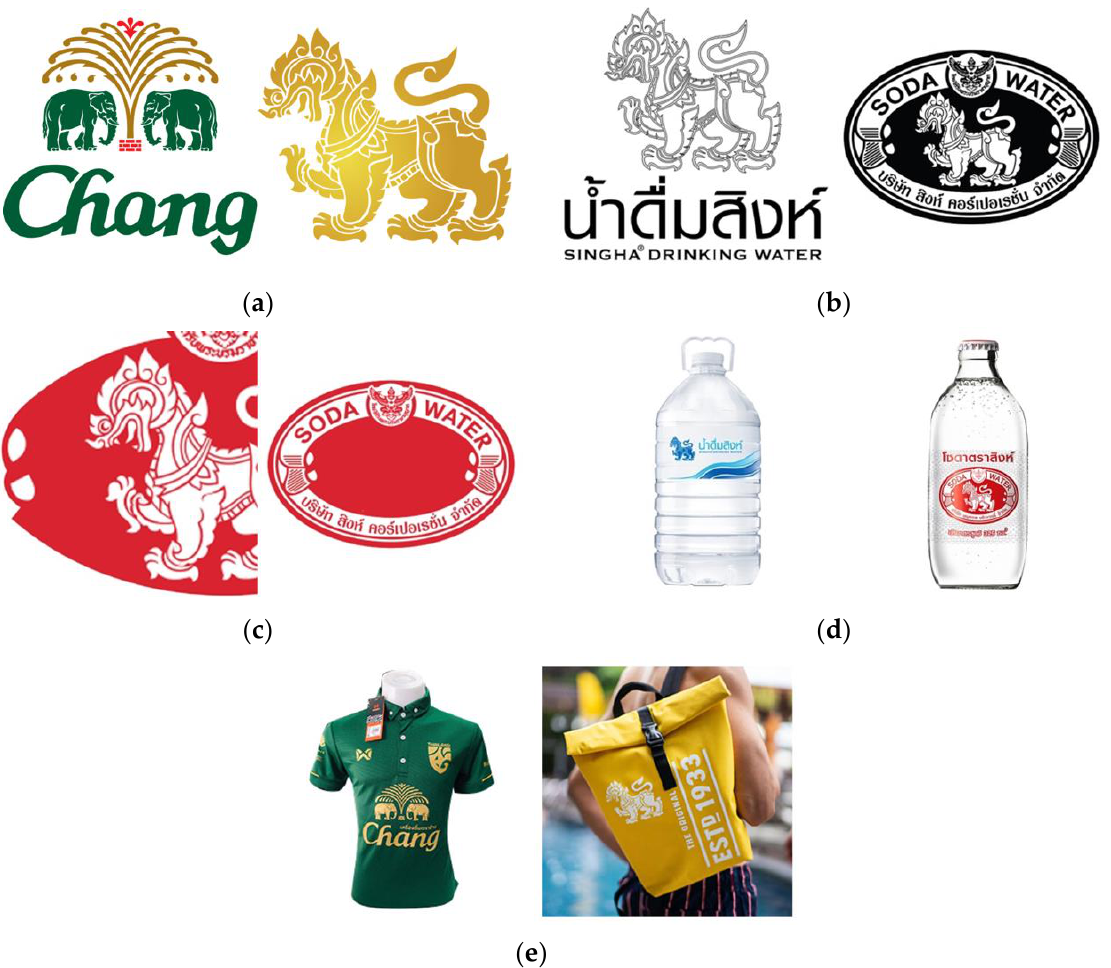
Figure 1. Examples of alcohol-related logos used in the survey: ( a ) original logo of beer; ( b ) black logo of drinking and soda water; ( c ) partial logo of soda water; ( d ) non-alcoholic beverage with package of drinking and soda water; and ( e ) logo on other merchandise.